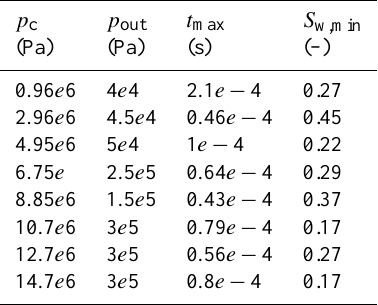
Table 2. Outlet pressure p out , maximum model time interval t max and minimum-reached wetting phase saturation S w, min for each corresponding capillary pressure p c for the µ -CT-based pore net- work geometry model.